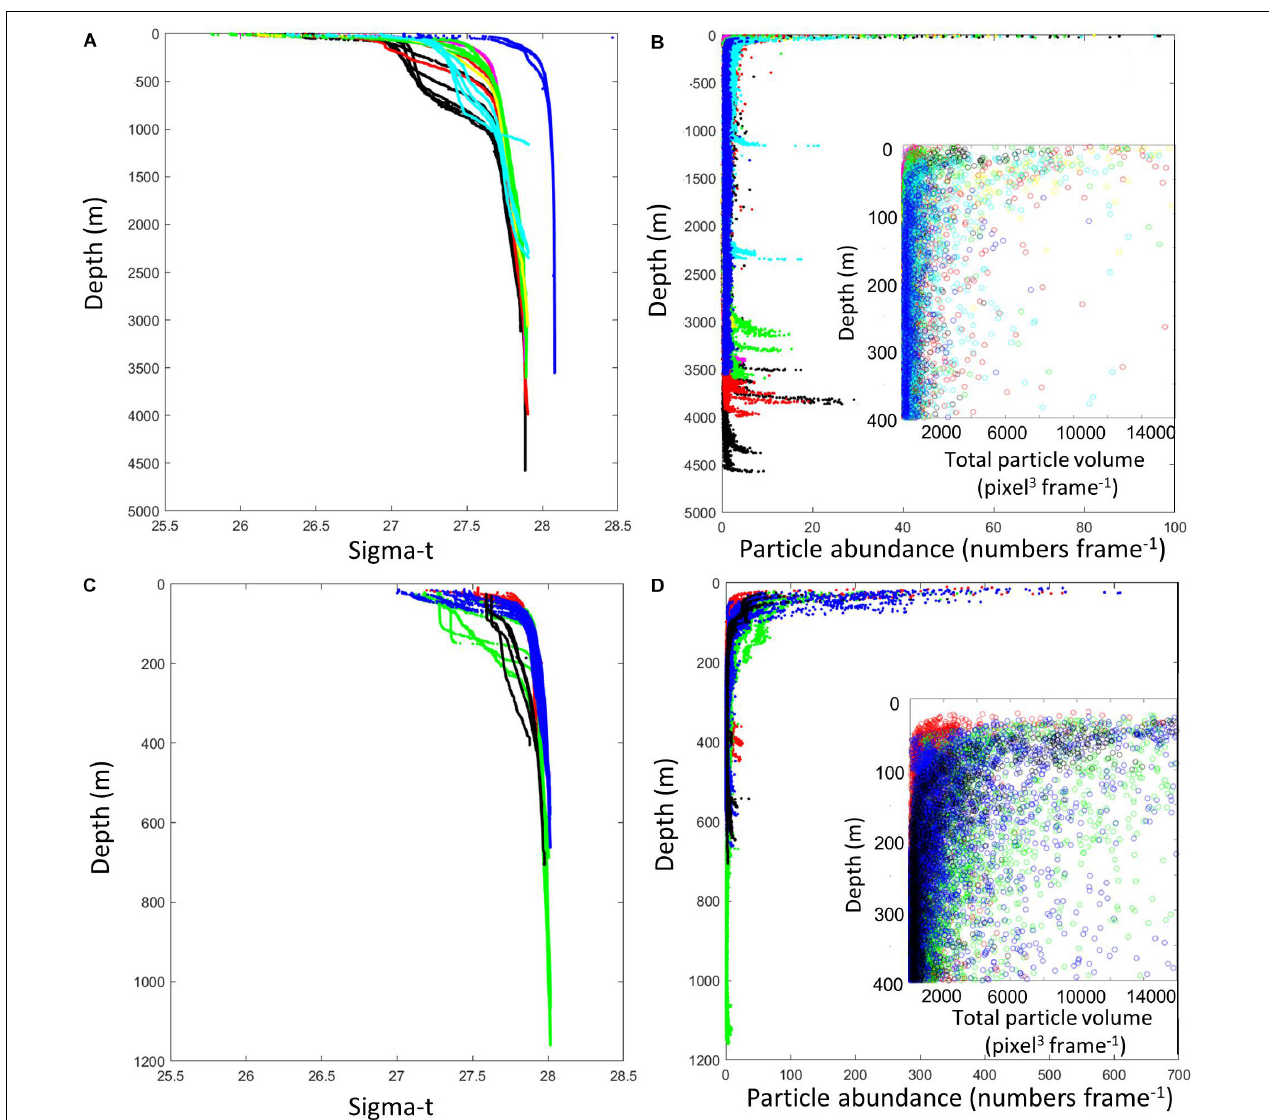
FIGURE 2 | Density (Sigma- t ) and particle abundance (numbers per video frame), respectively, during the North Atlantic (A,B) and the Ross Sea (C,D) expeditions. The insets show a close-up of total particle volume (pixel 3 frame - 1 ). Total particle volume is a better predictor of particle carbon than is particle abundance because average particle volume changed with depth. Note that particle abundances are plotted at different scales for the two regions, with the open North Atlantic having lower abundance than the Ross Sea. Pronounced benthic nepheloid layers were present in most casts in both regions. Color codes of data points in the North Atlantic (A) : black, stations east of the Charlie Gibbs Fracture Zone (CGFZ); red, southern trench of the CGFZ; magenta, station 12 west of the CGFZ; green, northern trench of the CGFZ; yellow, station 17; cyan, stations 18–21; blue, Norwegian Sea, Arctic. Color codes of data points in the Ross Sea (B) : red, south site; green, Terra Nova Bay; blue, north site; black, transect